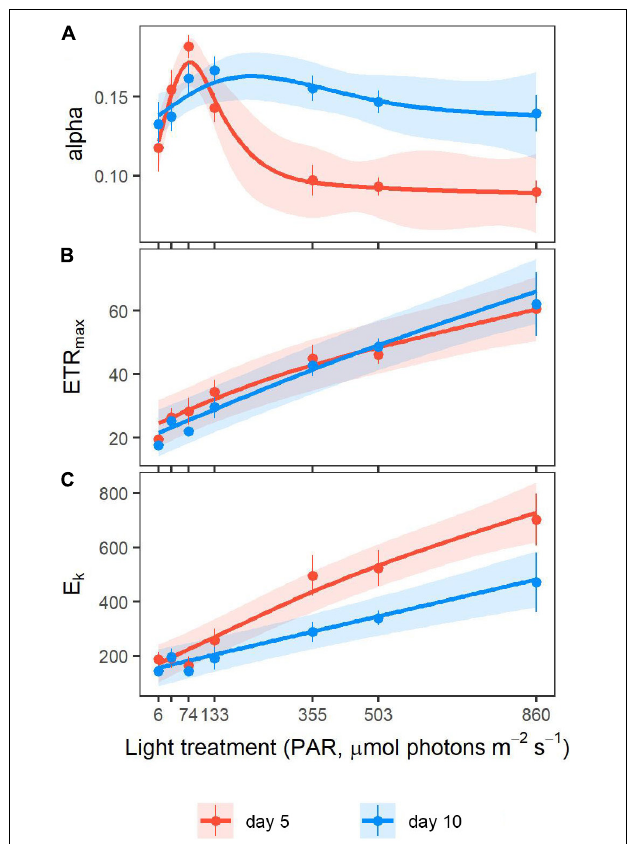
FIGURE 2 | Photosynthetic parameters derived from Rapid Light Curves (RLCs) after 5 (red) and 25 (blue) days of light exposure. Dotted values are mean ± SE ( n = 5–9 shoots) for each light treatment. Lines correspond to the values fitted by hierarchical generalized additive models (HGAM) with a 95% CI. (A) Alpha (initial slope of the RLC), (B) maximum electron transport rate (ETR max , µ mol electrons m − 2 s − 1 ), and (C) onset of light saturation (E k , µ mol photons m − 2 s − 1 ).